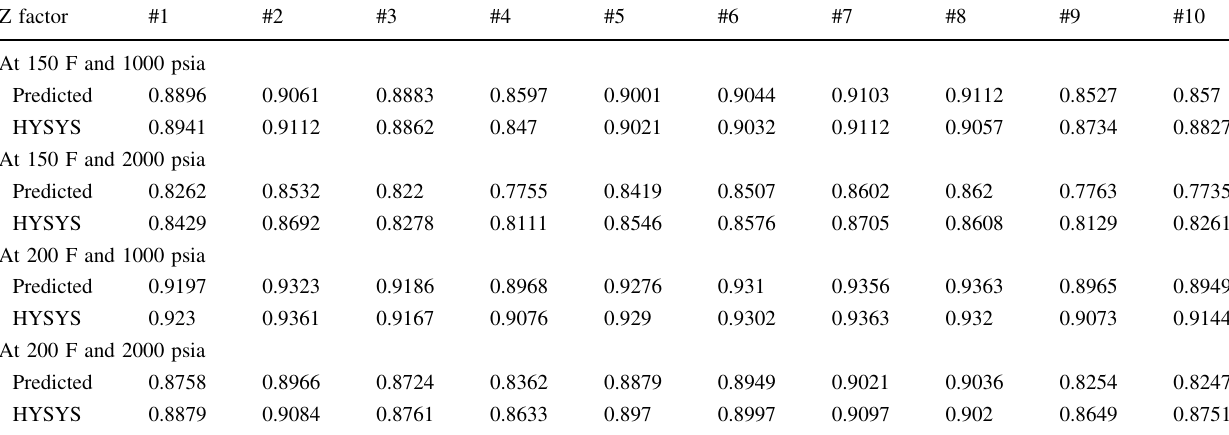
Table 5 Evaluation of Z factor at different pressure and temperature